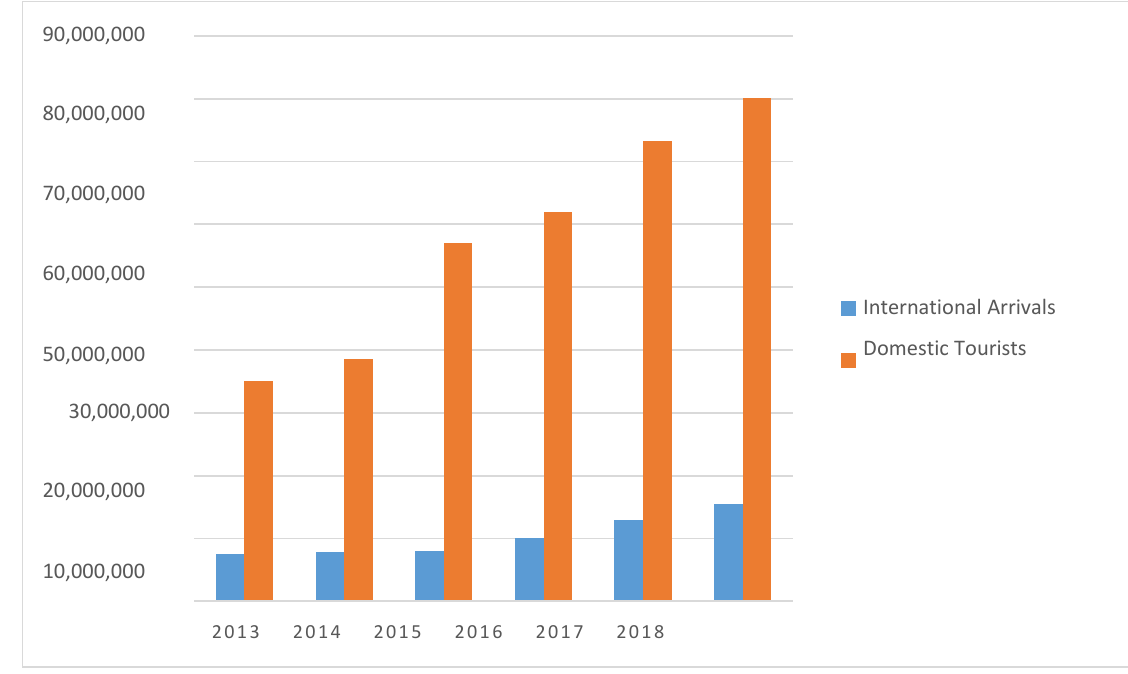
Figure 2. Number of tourists in Viet Nam 2013-2018 (General Statistics Office of Viet Nam,